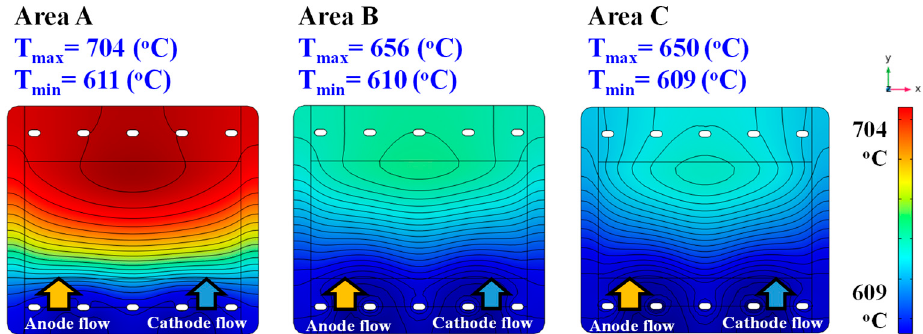
Figure 17. Temperature distribution according to the reforming area.